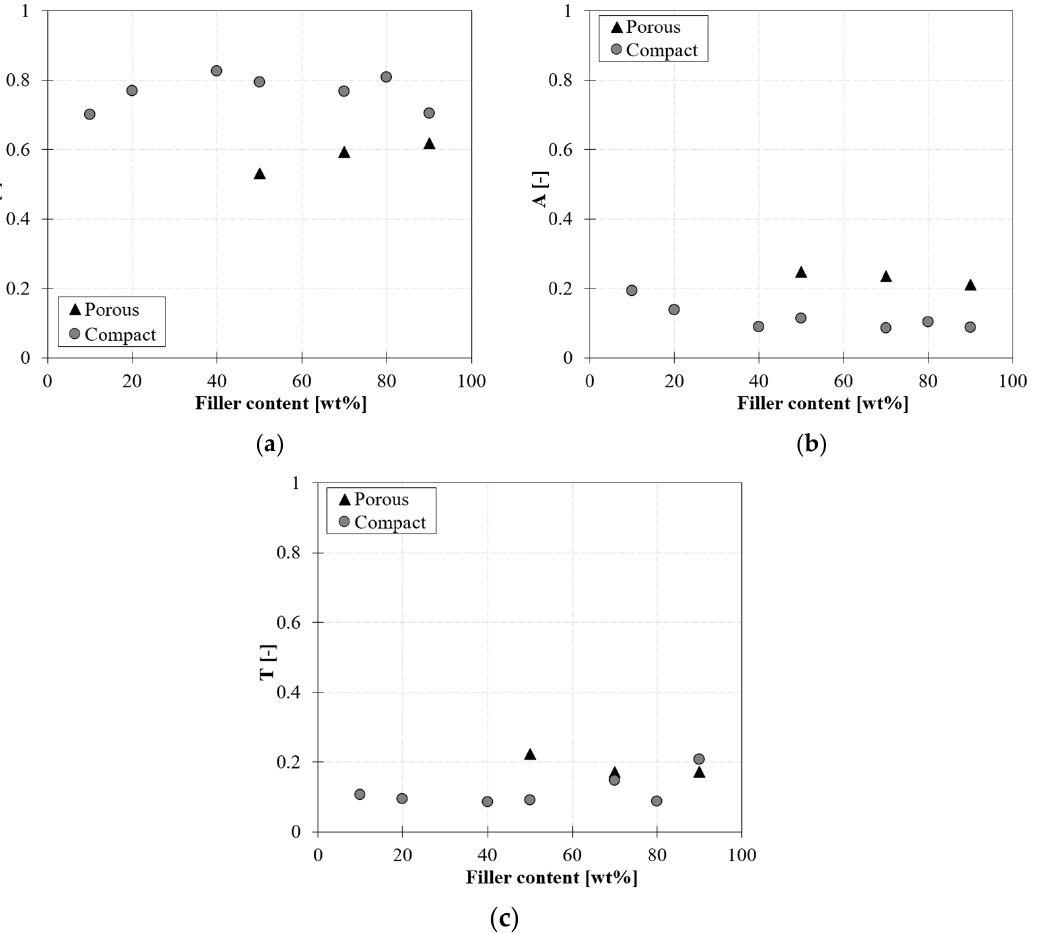
Figure 4. Reflection ( a ), absorption ( b ), and transmission ( c ) contributions of compact and porous samples at a different filler content at 10 GHz.